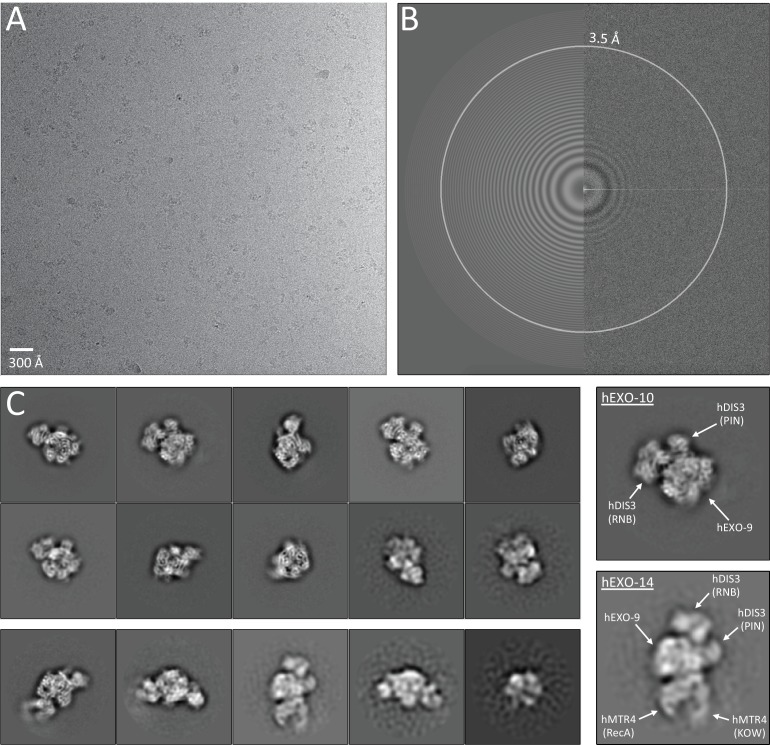
Cryo-EM data collection and 2D classification.(A) An example of the cryo-EM micrograph collected on a FEI Titan Krios operated at 300 kV, equipped with a K2 Summit camera. The scale bar corresponds to 300 Å. (B) Thon-ring image of the same micrograph as in (A) following the contrast transfer function estimation with GCTF. Zeros between the Thon rings in the experimental image (right half) coincide with the ones in the model (left half). (C) Left panels represent the reference-free 2D class averages from the hEXO-10 (top) and the hEXO-14 (bottom). Two panels on the right highlight domain organization of both hEXO-10 (top) and hEXO-14 (bottom).